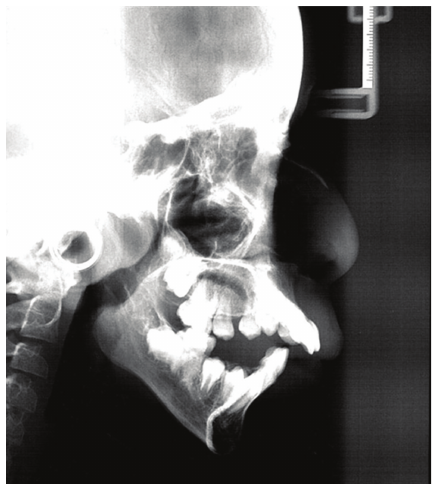
Figure 8: Lateral cephalogram showing mandibular deficiency and vertical growth